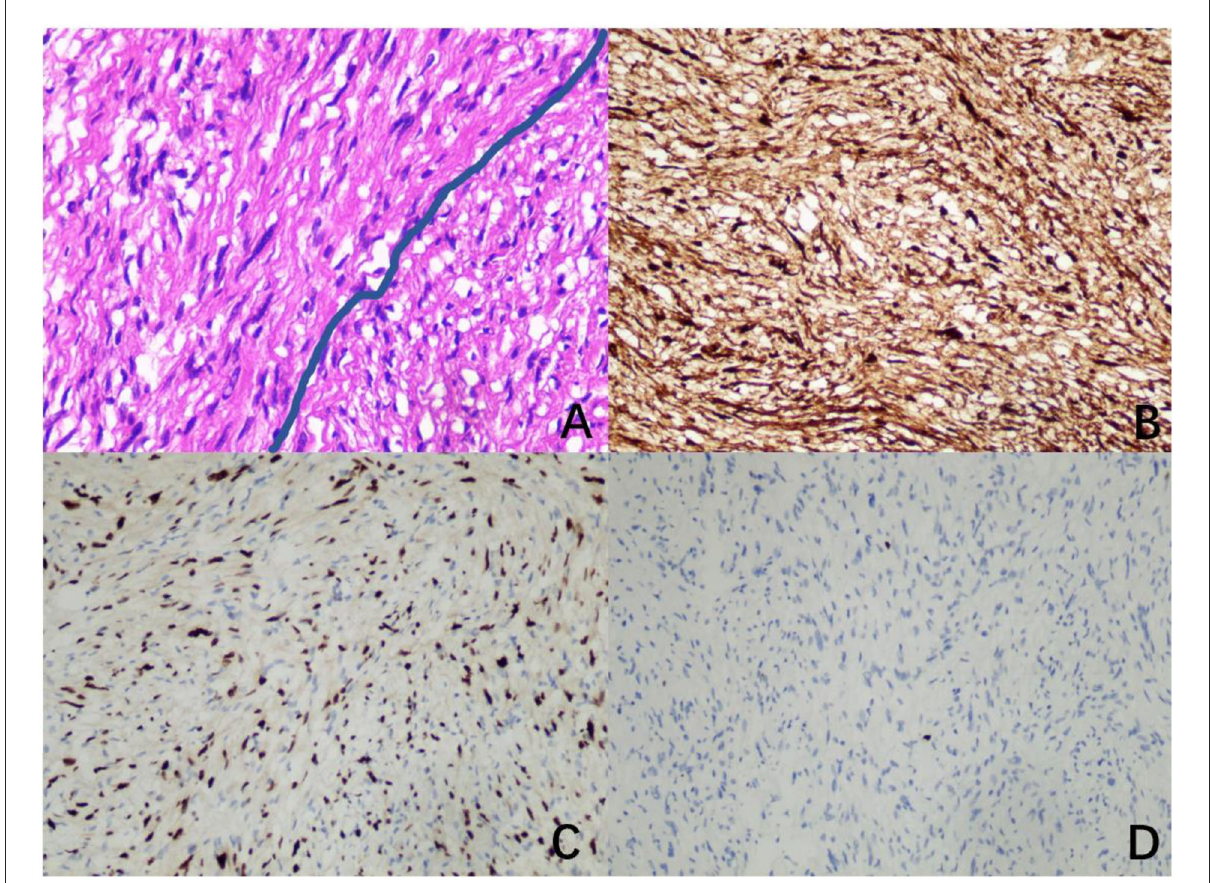
FIGURE4 Image of pathology. (A) A biphasic pattern of Antoni A and Antoni B (hematoxylin and eosin, × 400). (B) Diffusely and strongly positive immunoreactivity for S100 (immunohistochemistry for S100, × 200). (C) Positive immunoreactivity for SOX10 (immunohistochemistry for SOX10, × 200). (D) Less than 1% positive immunoreactivity for KI67 (immunohistochemistry for KI67, ×